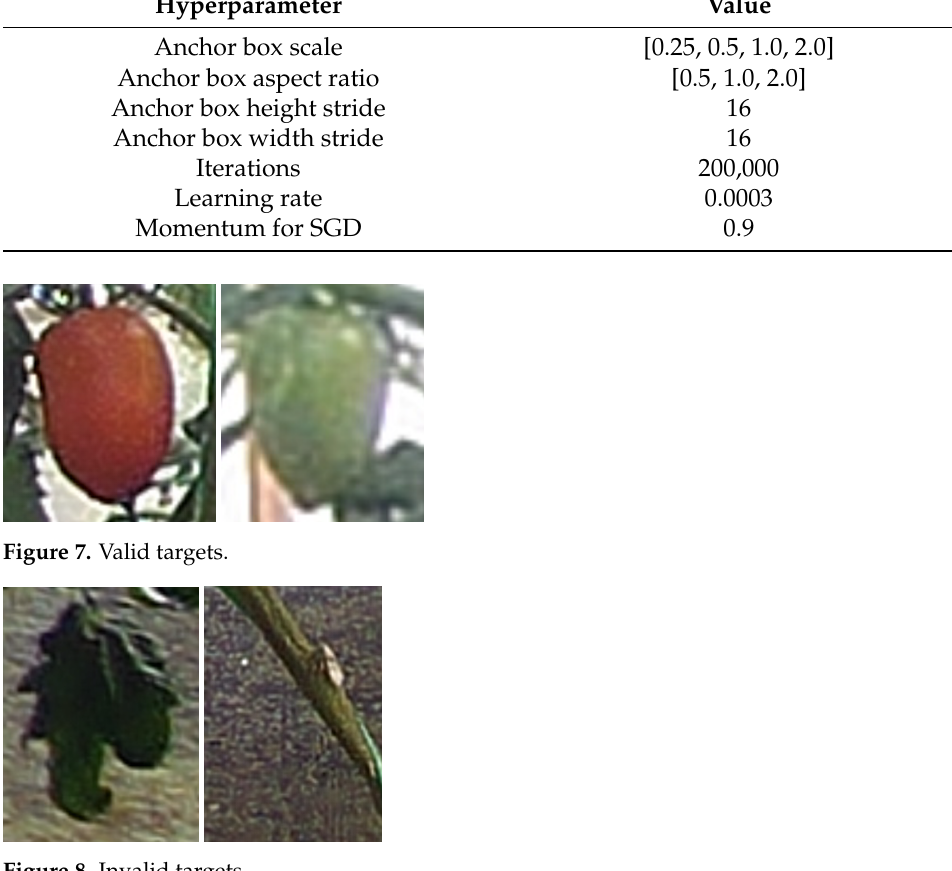
Figure 8. Invalid targets.